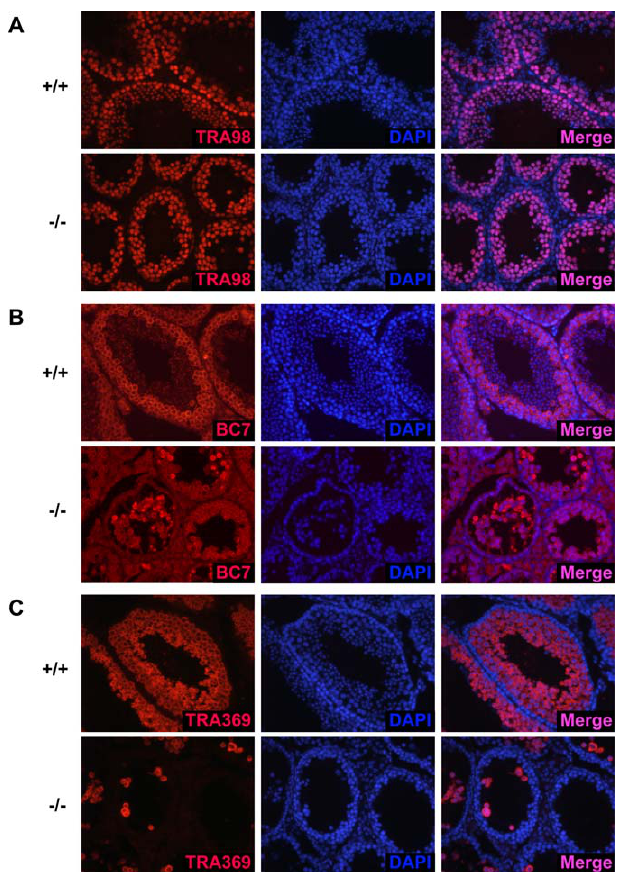
Figure 3. Prophase I Arrest of Dmrt7 Mutant Germ Cells Testis sections from 6-wk-old wild-type ( þ / þ ) and Dmrt7 mutant ( (cid:2) / (cid:2) ) littermates stained with stage-specific antibodies specific to spermato- genic cells. (A) TRA98 antibody strongly stains spermatogonia, which are present in wild-type and mutant. (B) BC7 antibody stains spermatocytes, which are present in wild-type and mutant. (C) TRA369 antibody stains pachytene and later germ cells, which are severely deficient in the mutant testis.